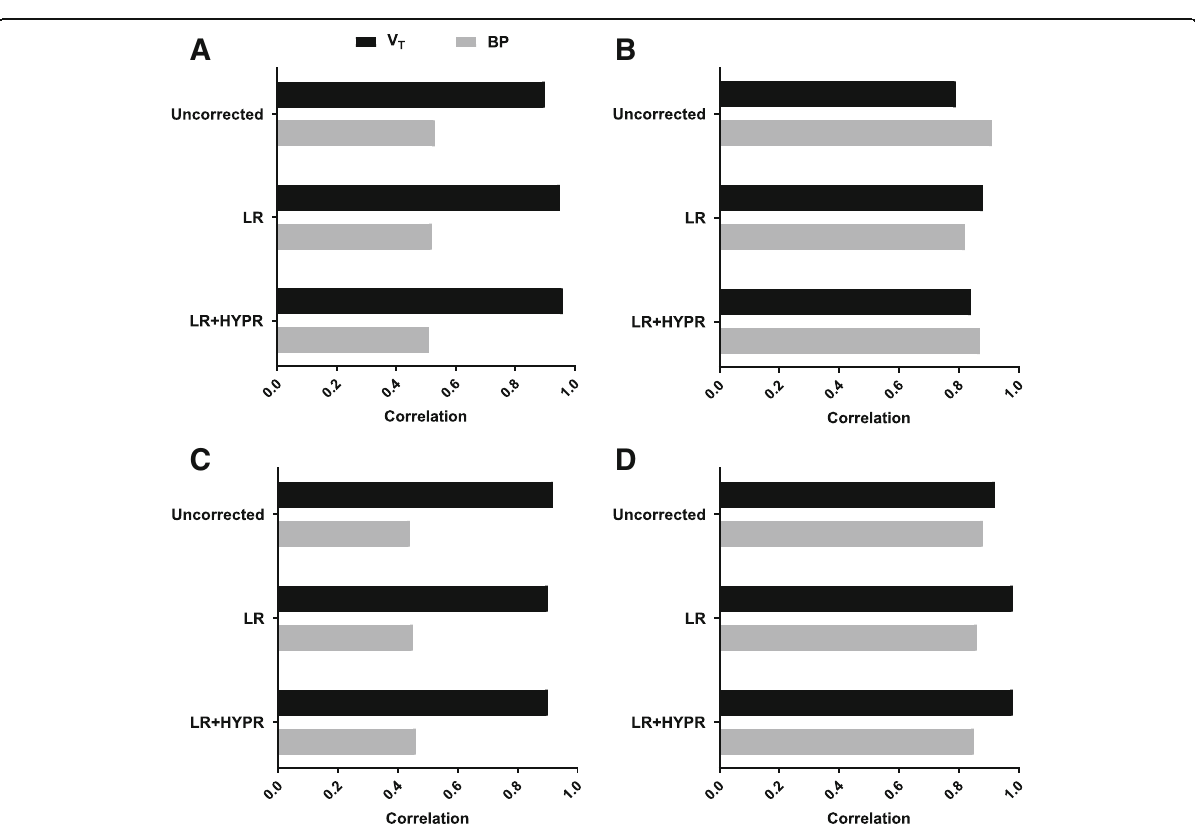
Fig. 5 Correlation (Spearman) between changes in kinetic parameter estimates vs. simplified metrics during treatment with TKI, with and without PVC. Results shown are for SUV at 7 ( a ) and 28 ( b ) days, and for TBR at 7 ( c ) and 28 ( d ) days after treatment